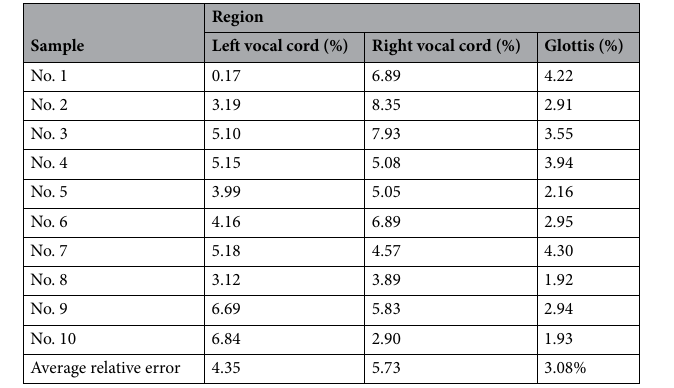
Table 1. Average relative error of three parts of ten